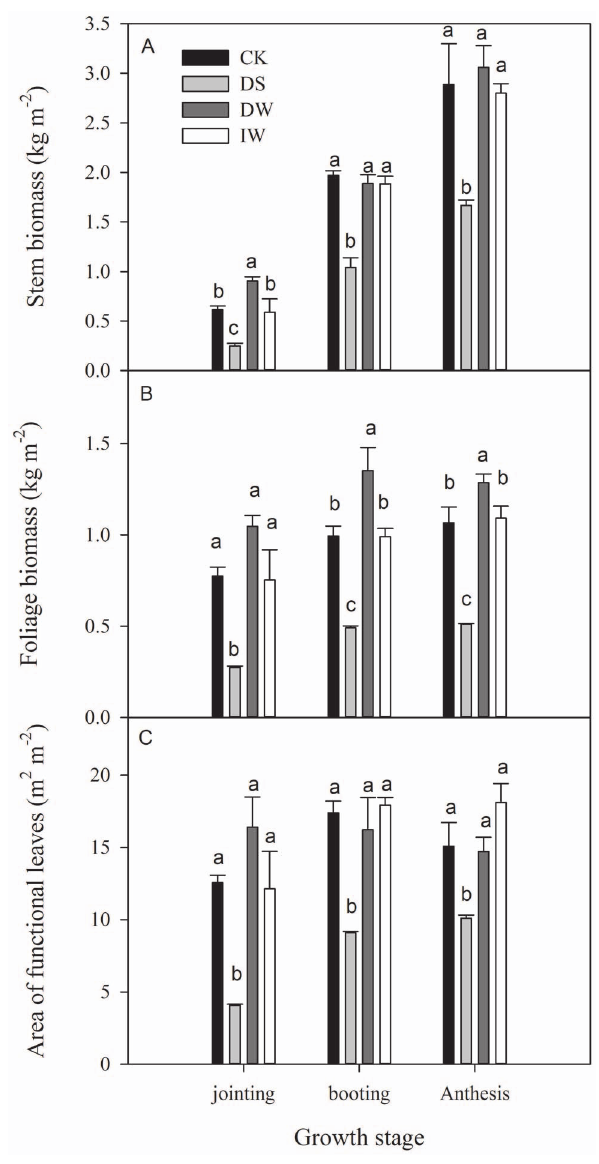
Figure 5. Season changes in (A) stem biomass, (B) foliage biomass and (C) areas of functional leaves of winter wheat under four treatments (CK, DS, DW and IW). Data were calculated based on 1 m 2 soil area. Different lower case letters indicated significant difference ( P , 0.05).